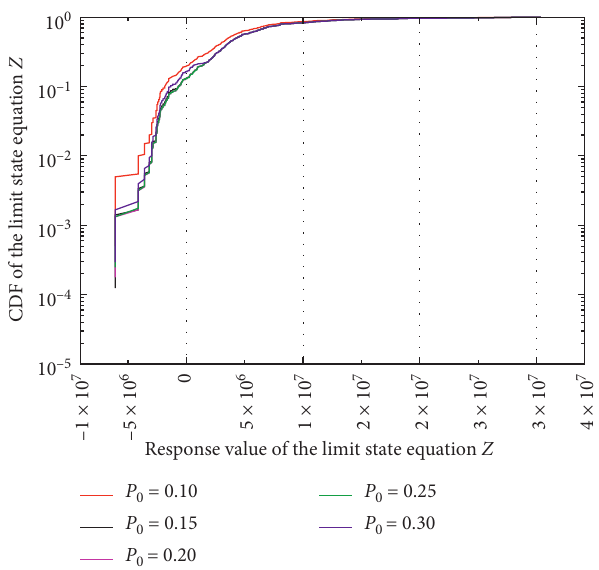
Figure 10: CDF of survival rate at Table 5: Estimated failure probabilities and the number of samples with different p Survival rate P (%) Conditional failure probability p 0